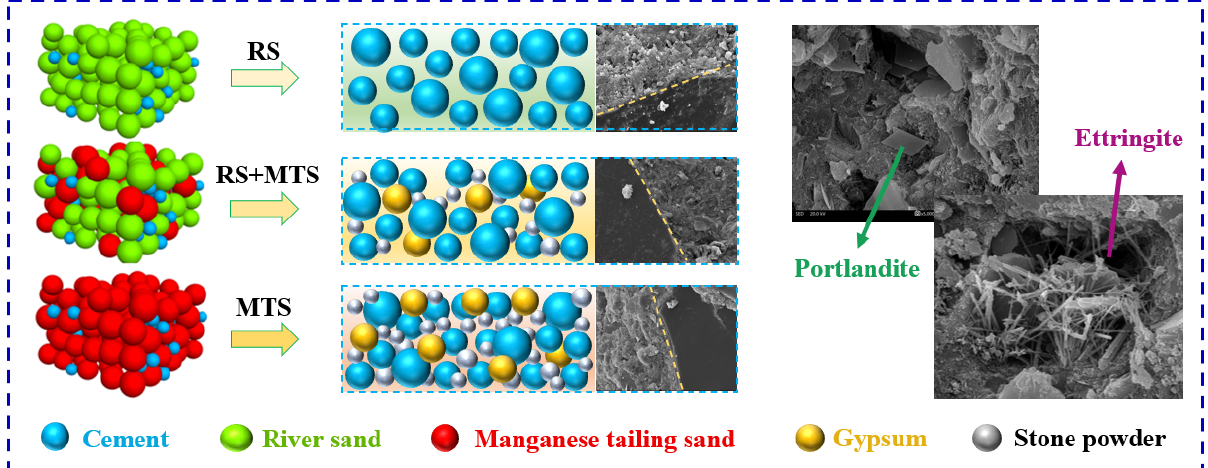
Figure 12. Schematic diagram of concrete prepared with MTS instead of RS.